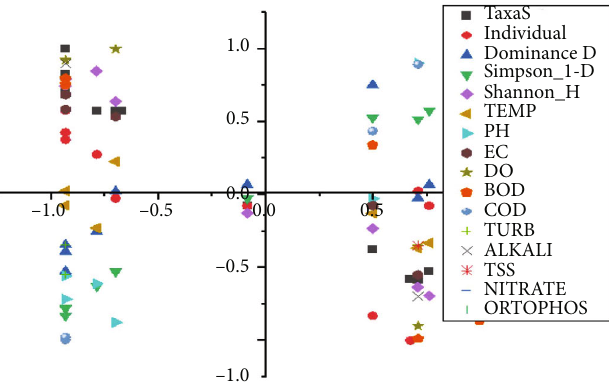
Figure 3: Canonical correspondence analysis macroinvertebrates and physiochemical of the study